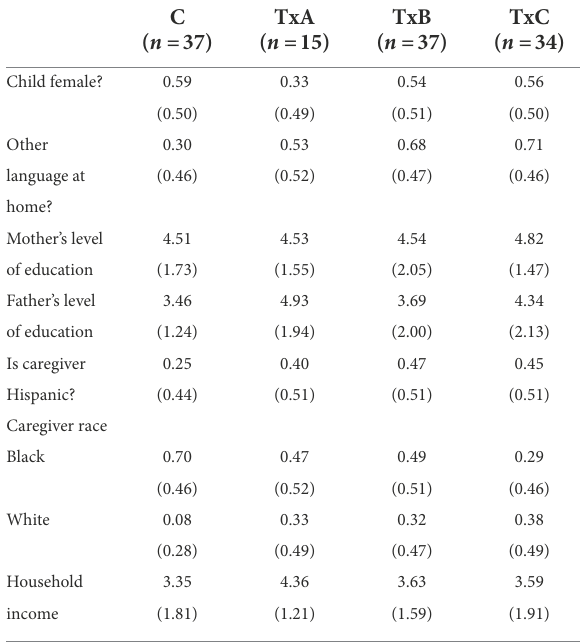
TABLE 1 Demographic characteristics ( n =